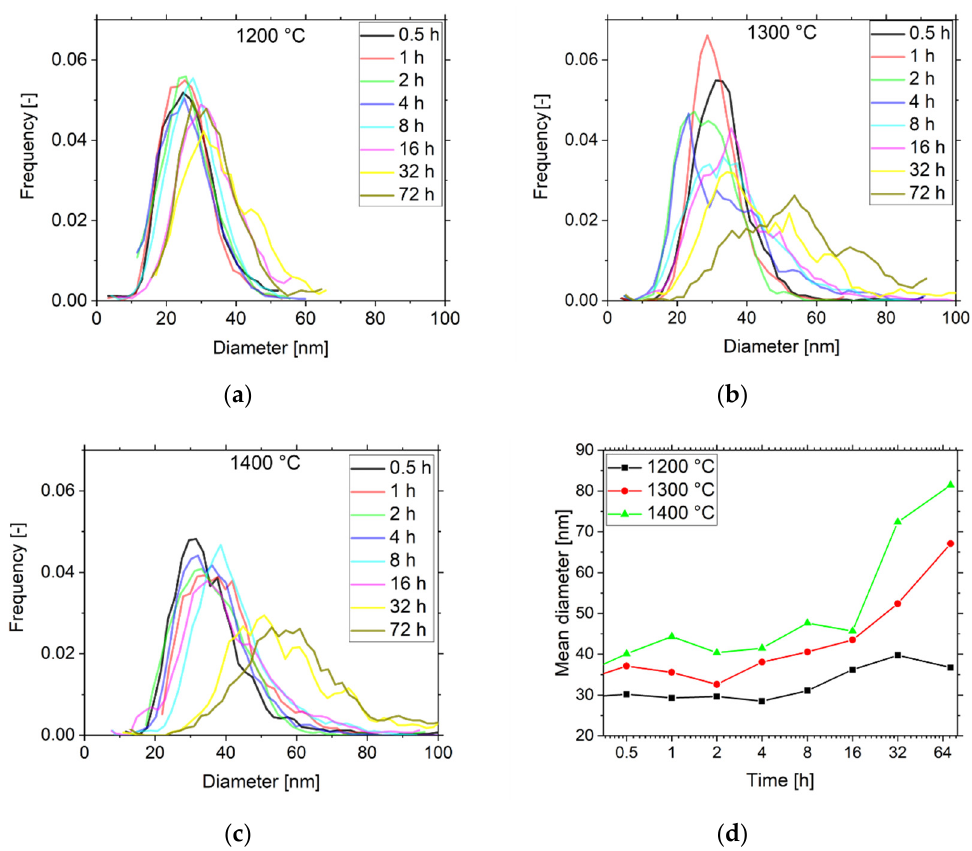
Figure 5. Oxide diameter normalized distributions for all specimens aged at ( a ) 1200 °C, ( b ) 1300 °C, ( c ) 1400 °C and ( d ) dependency of mean oxide diameter on time for all temperatures.